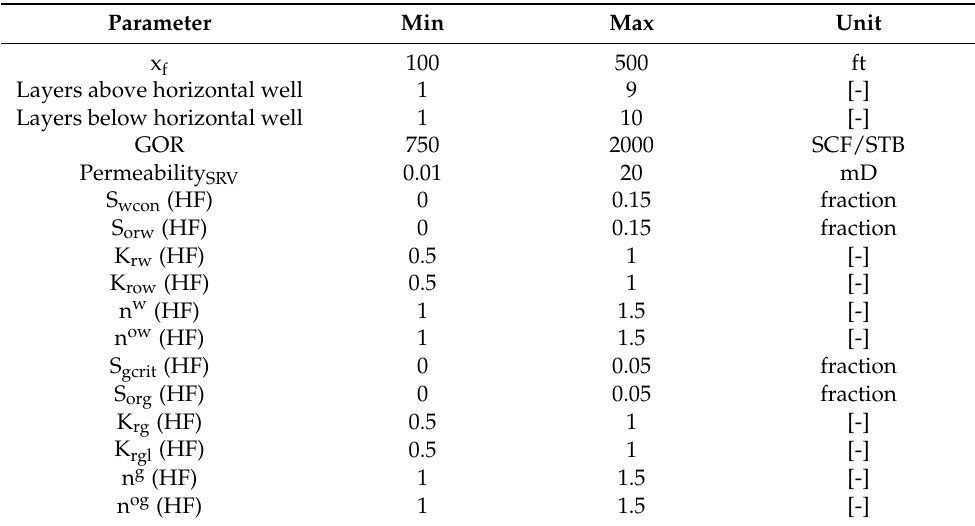
Table 2. The list of the parameters (and their ranges) used in history matching with the CMG CMOST simulator.